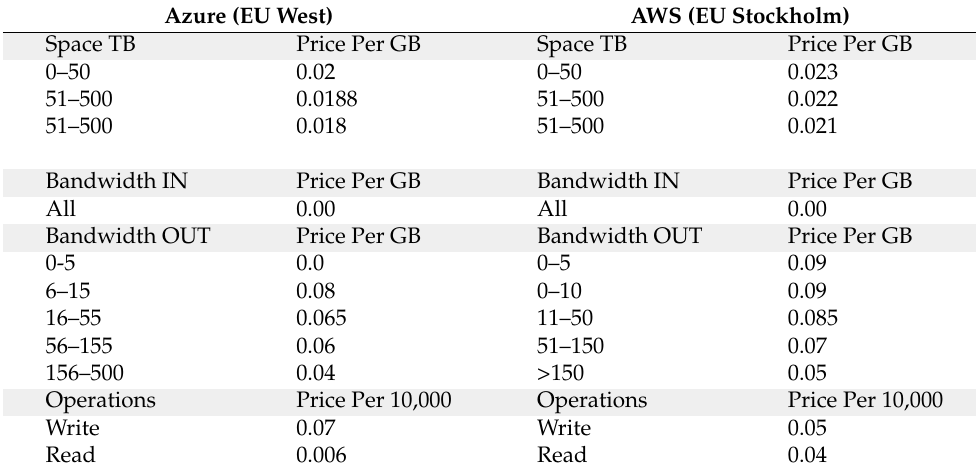
Table 1. Example cost data collected for Azure and AWS.